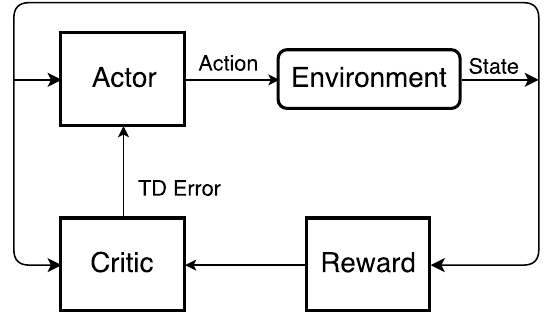
Figure 5. A regular actor–critic model. TD: temporal